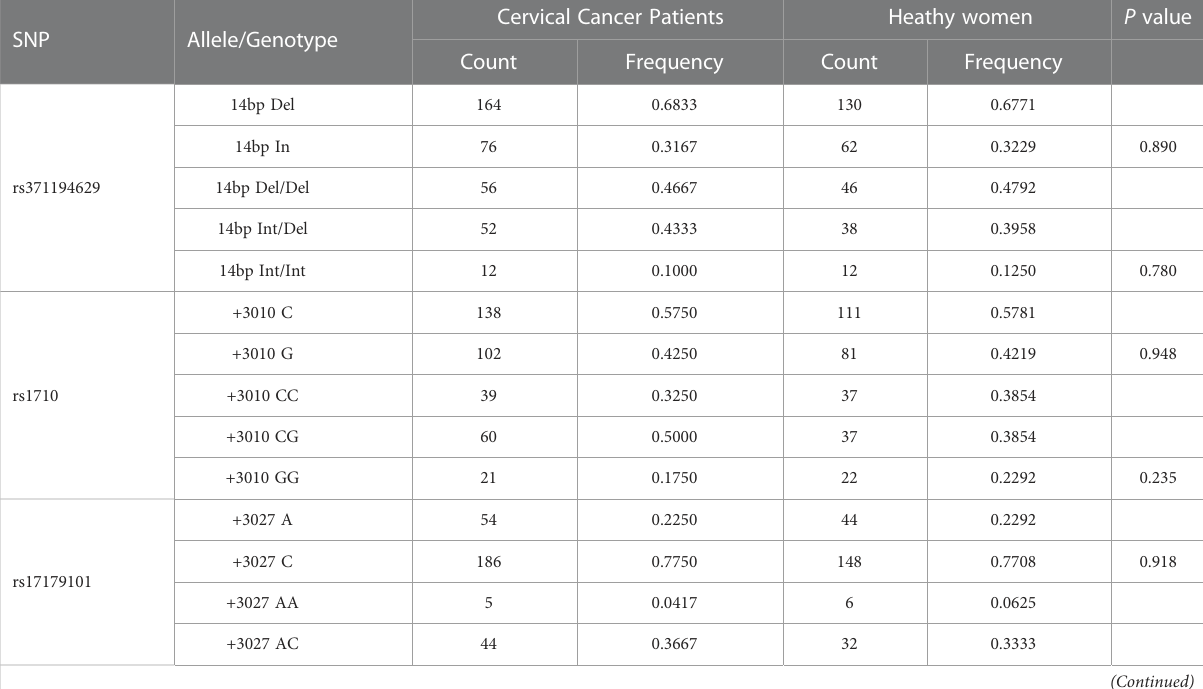
TABLE 2 Comparisons of the HLA-G 3 ’ UTR allelic and genotypic frequencies between patients and